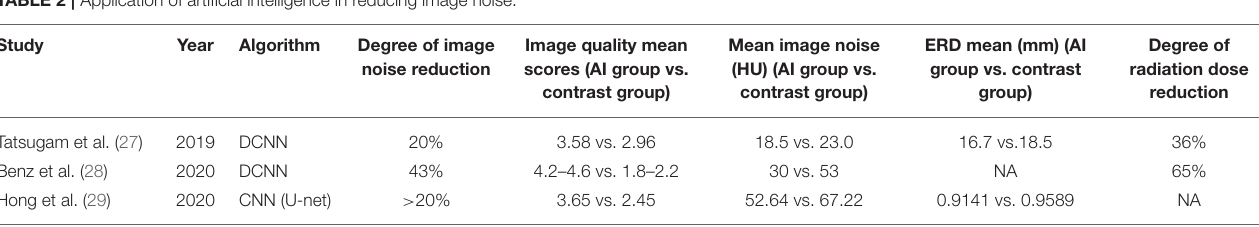
TABLE 2 | Application of artificial intelligence in reducing image